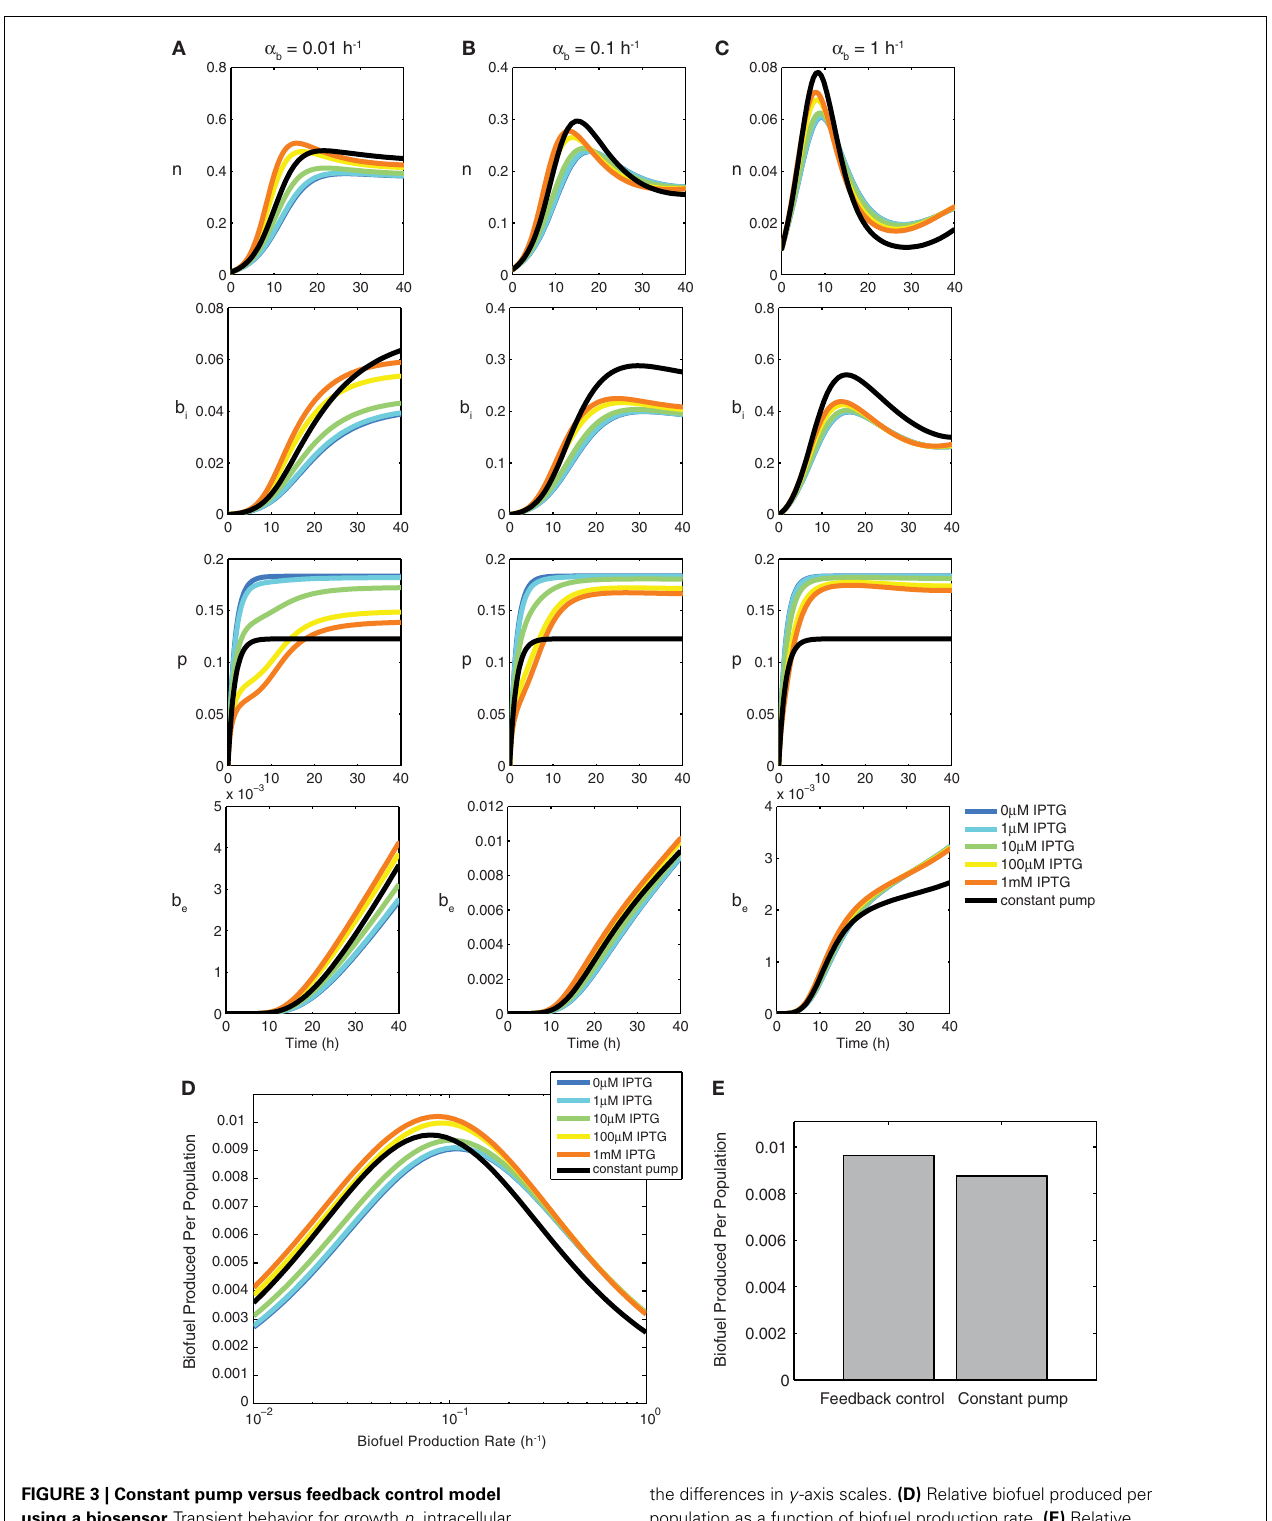
FIGURE 3 | Constant pump versus feedback control model using a biosensor. Transient behavior for growth n , intracellular biofuel b i , pump expression p , and extracellular biofuel b e for biofuel production rates α b of (A) 0.01h − 1 , (B) 0.1h − 1 , and (C) 1h − 1 . Note